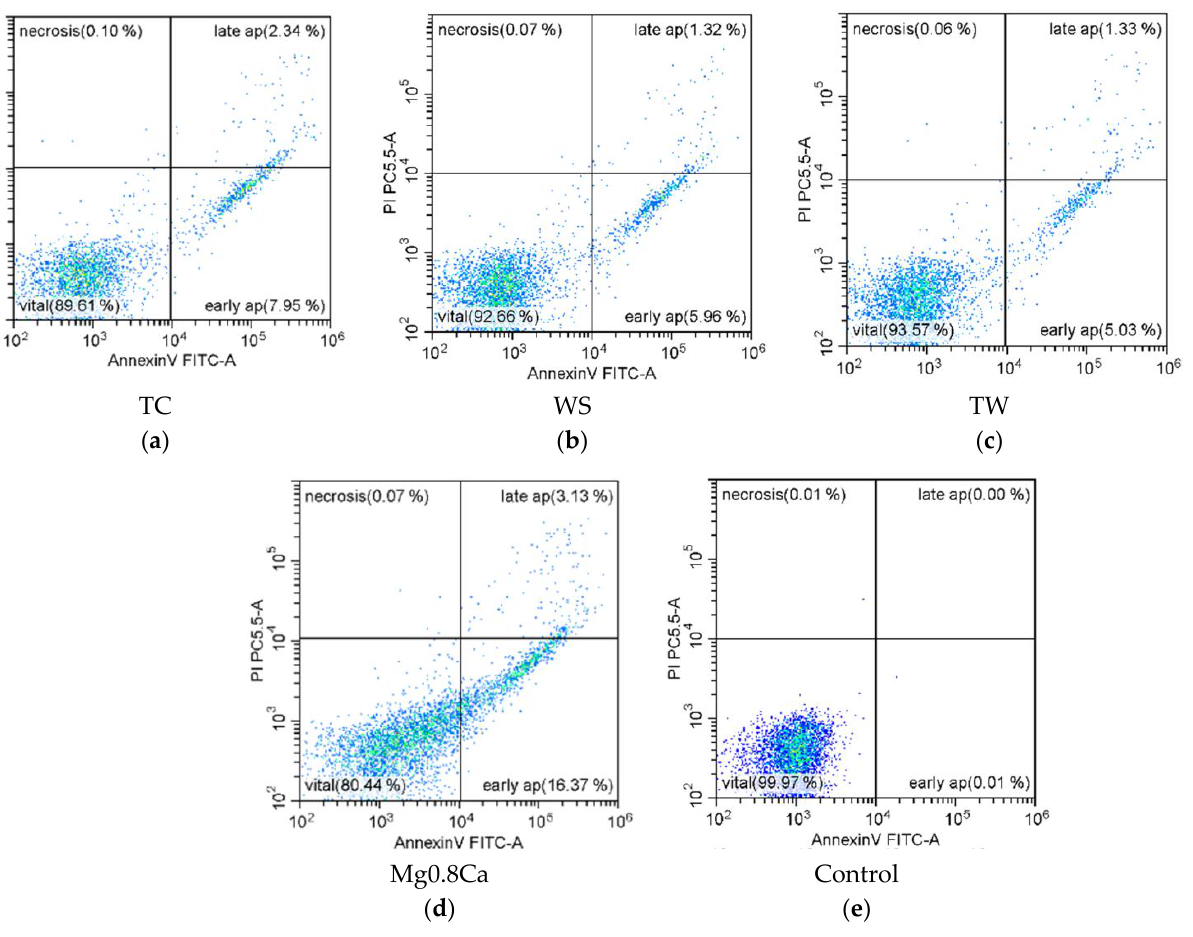
Figure 18. NIH/3T3 cells after incubation with the samples TC ( a ), WS ( b ), TW ( c ), and alloy Mg0.8Ca ( d ); control (untreated cells) ( e ). The results of the research with the help of flow cytometry.